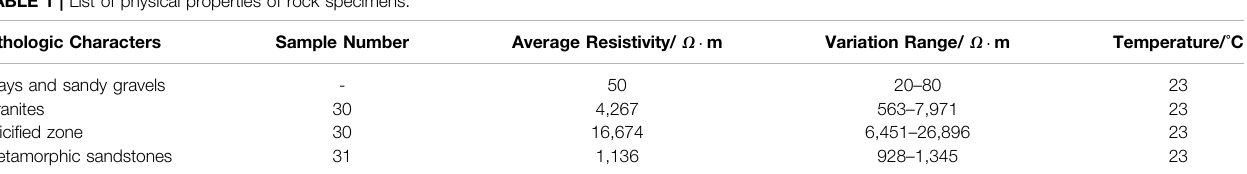
TABLE 1 | List of physical properties of rock